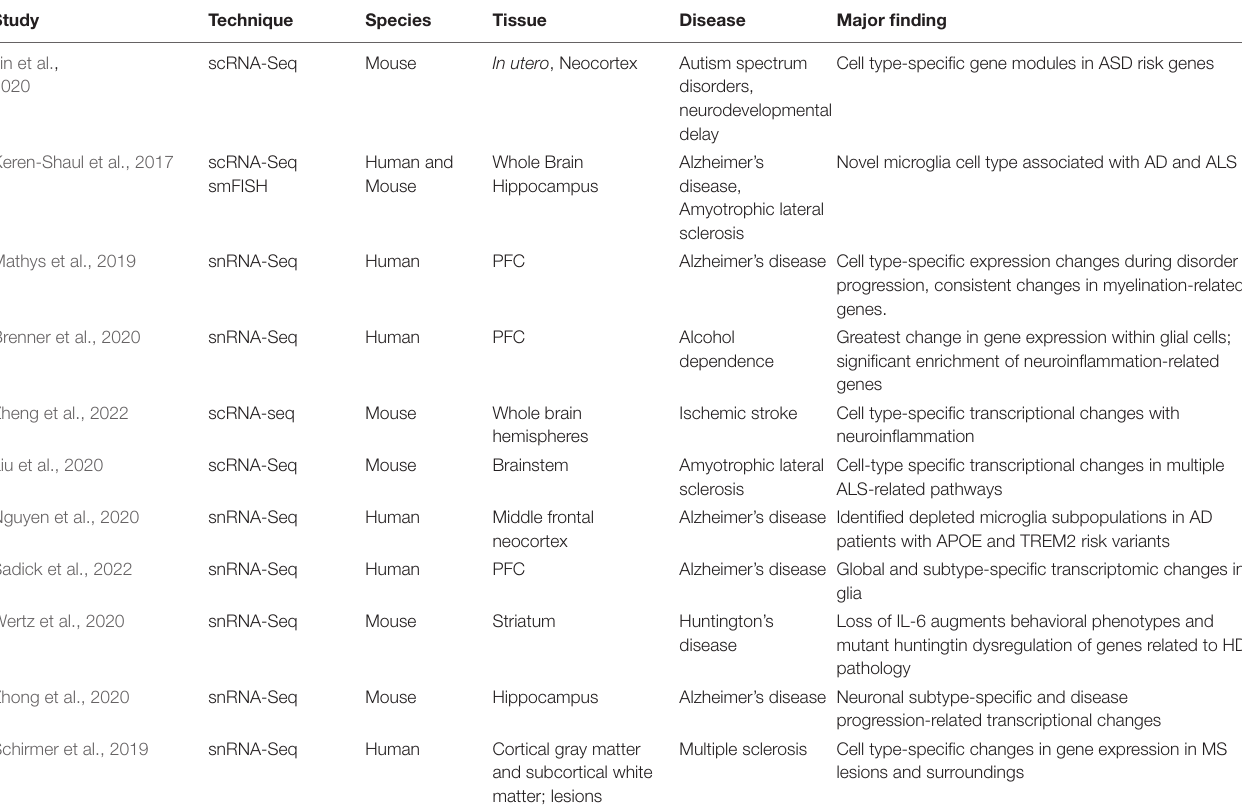
TABLE 2 | A selection of studies using cell-type-specific transcriptomic methods to study brain